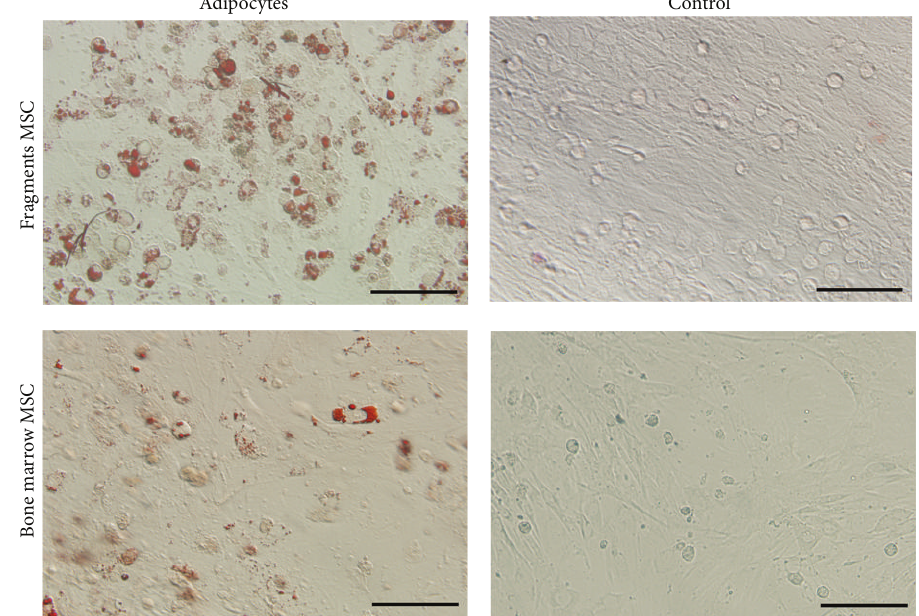
Figure6: Celladipogenic differentiation ofthefirstpassagefromcultured bonemarrowand bonefragments. Arrowshowed thelipiddroplets stained by oil red. Bar 50 𝜇